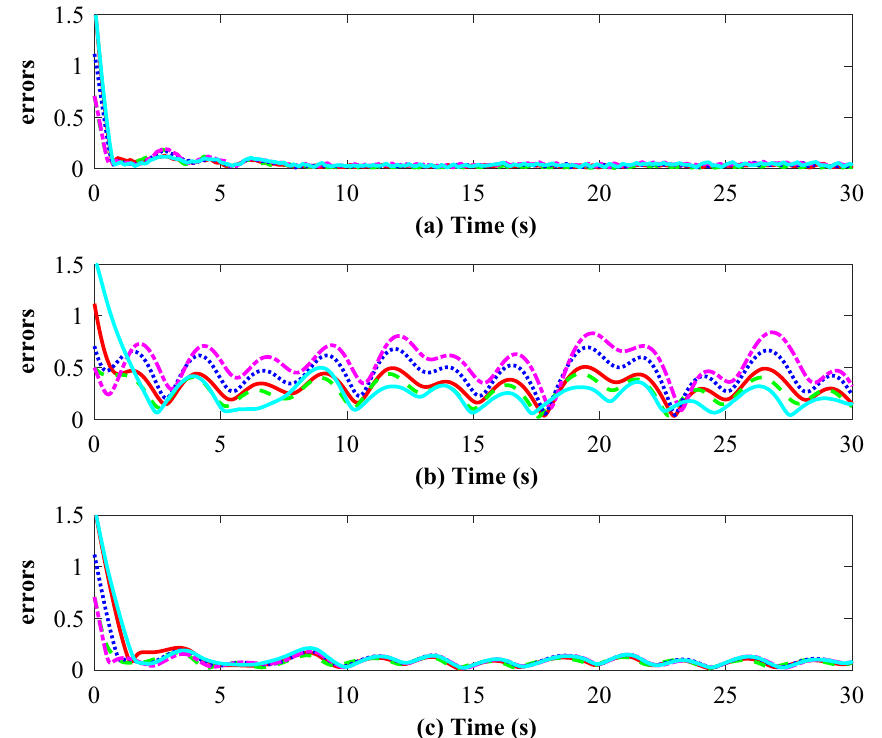
Figure 9. Simulation results: ( a ), ( b ) and ( c ) represents the consensus errors (m) for different agents under the control of proposed algorithm, algorithm 27 and algorithm 37 , respectively.